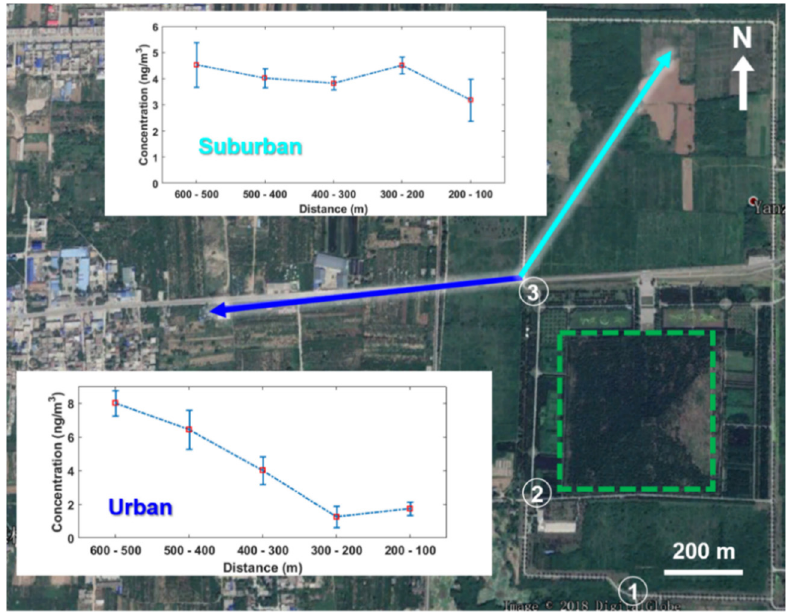
Figure 5. Comparison of mercury concentrations in two different directions. The light blue arrow is directed towards the suburban area and the blue arrow towards the Lintong urban area. The green dashed line indicates the position of the emperor Qin tomb